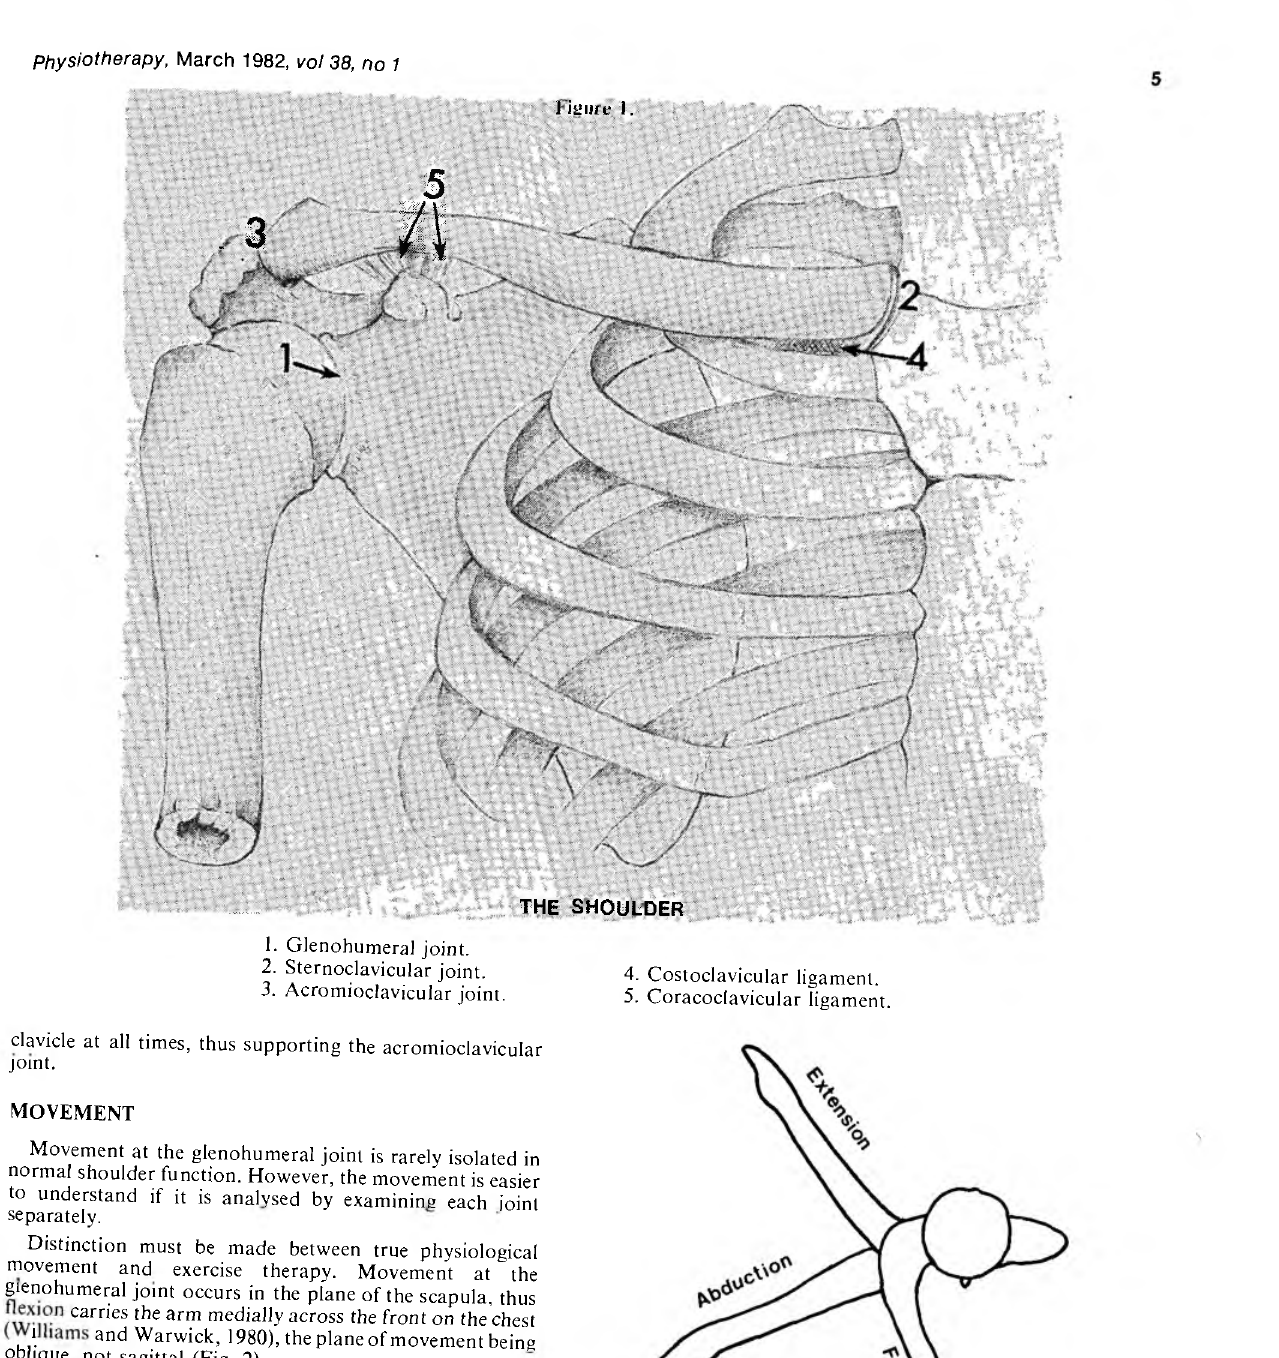
4. Costoclavicular ligament. 5. Coracoclavicular